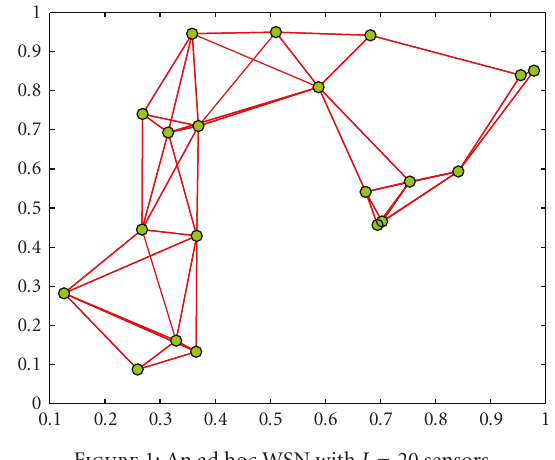
Figure 1: An ad hoc WSN with J = 20 sensors.